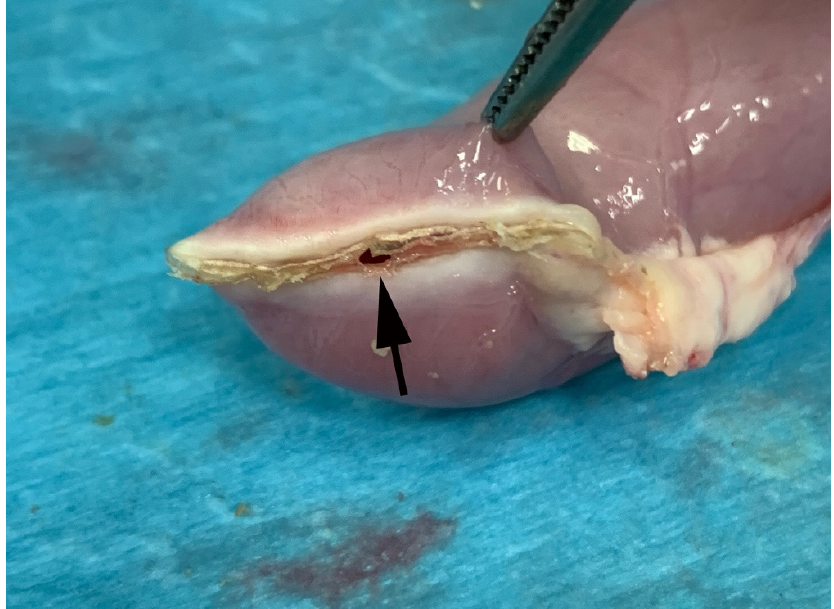
Figure 6. Representative image of RFVS-3 group specimen during BP test. Note sealing failure (black arrow).